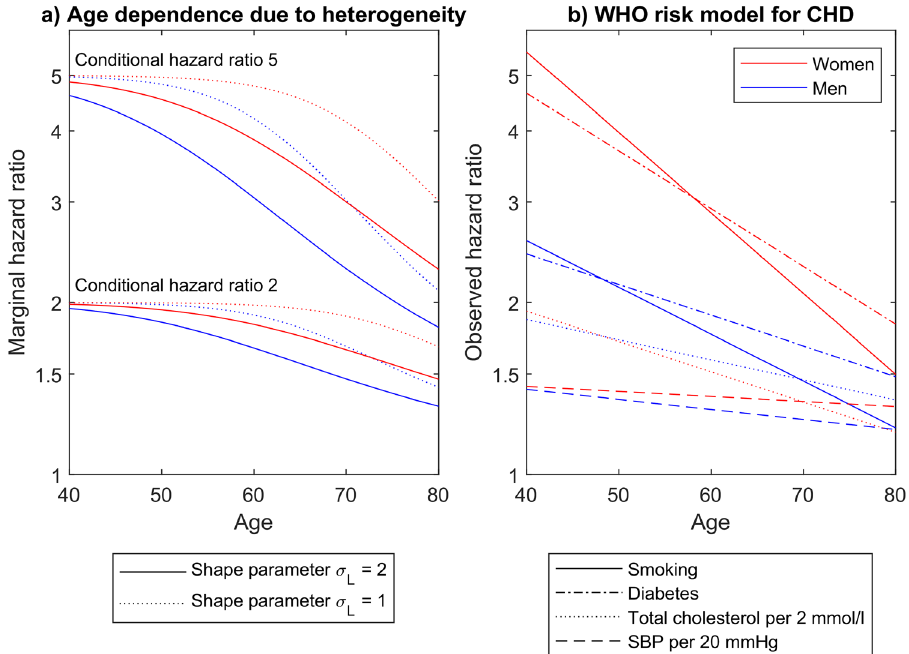
Figure 3. Predicted and observed age dependence of hazard ratios. ( a) Heterogeneity induced age dependence of the marginal hazard ratio for constant conditional hazard ratio values of 5 (lines originating at the top left) and 2 (other lines). Two different values of the shape parameter σ L were applied for unobserved heterogeneity. Exponentially increasing conditional hazards were assumed as shown in Fig. 2 for Germany. ( b) Age dependence of the hazard ratios of several risk factors for 10-year cardiovascular risk, as derived by the WHO CVD Risk Chart Working Group 38 . In both panels, red lines refer to women, blue lines to